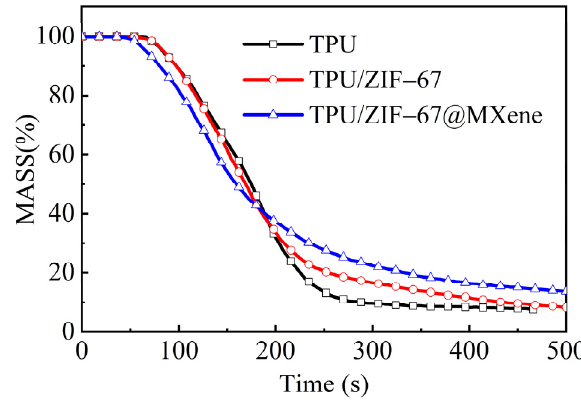
Figure 7. MASS curves of TPU composites.